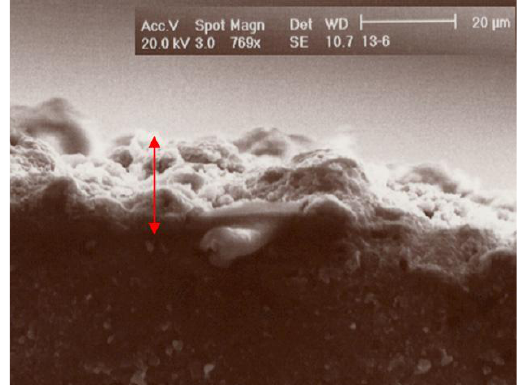
Fig. 7. SEM micrograph of the support